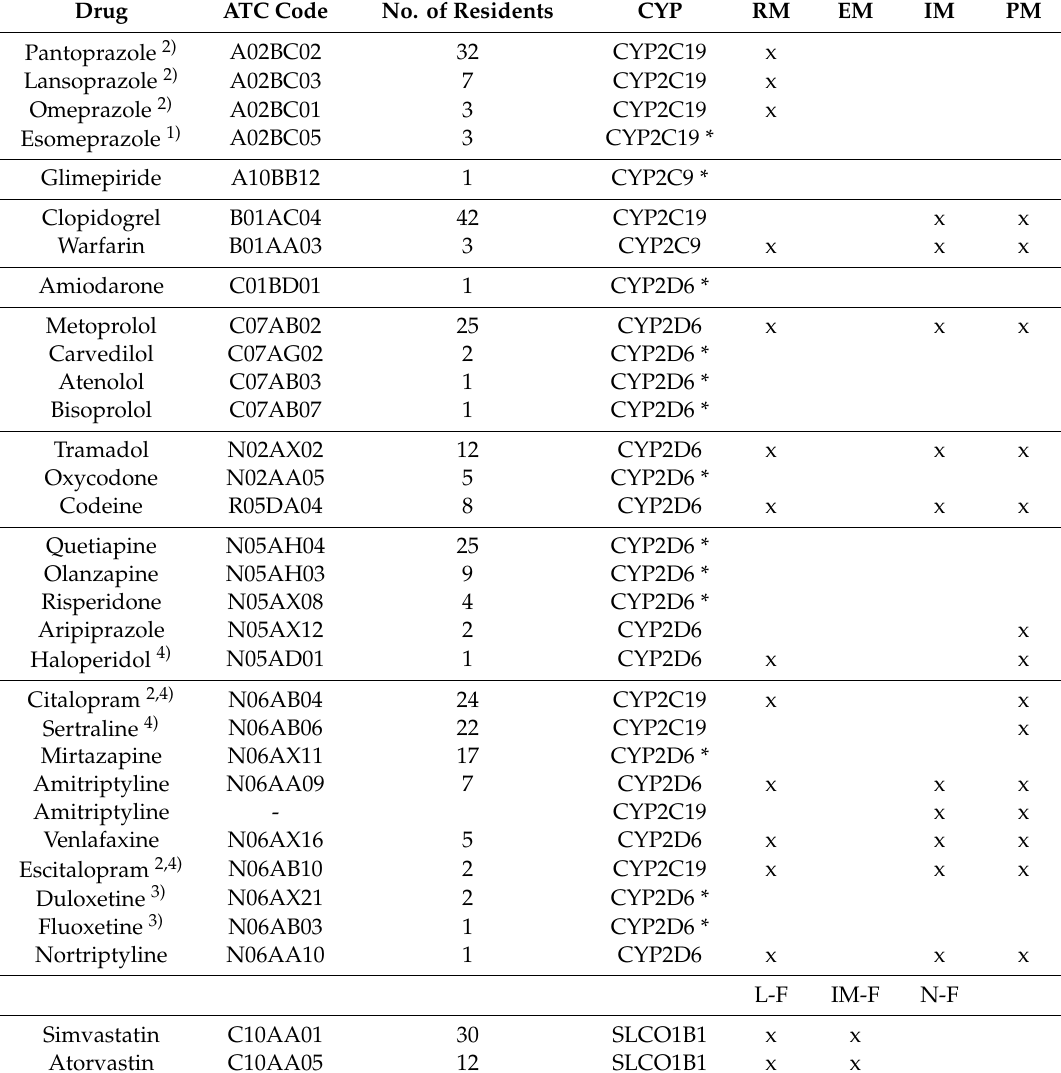
Table 3. No. of residents using drugs with PGx-based dosing